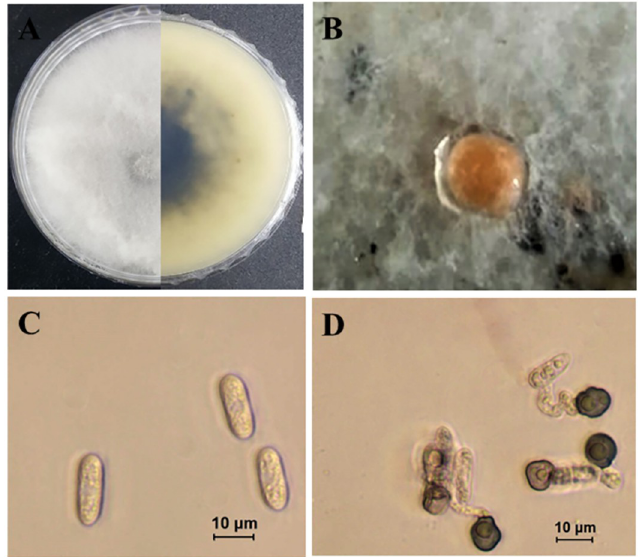
Fig 13. Morphological characteristics of C . siamense (isolate SPL2136). A: Colony on PDA above and below. B: Conidioma. C: Conidia. D: